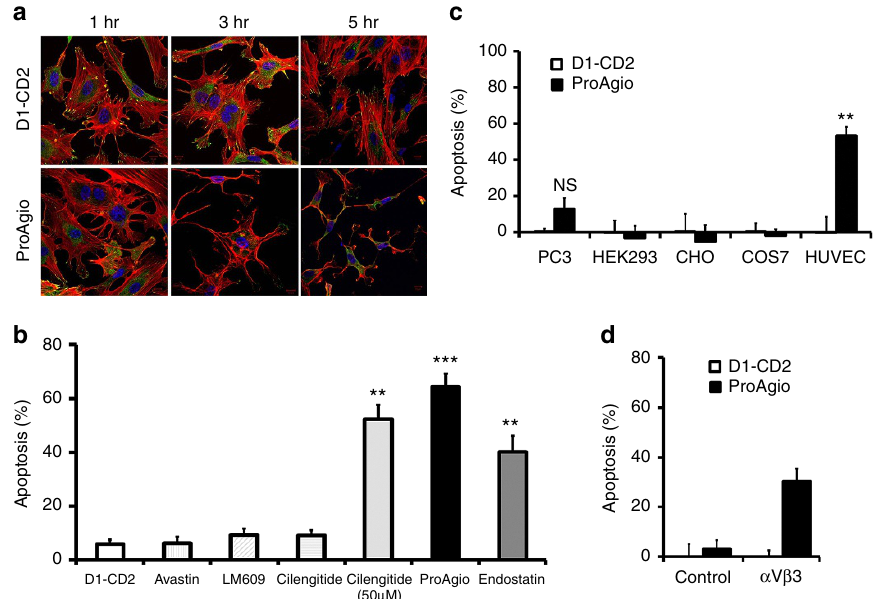
Figure 3 | ProAgio induces apoptosis via targeting integrin a v b 3 . ( a ) Representative confocal microscopic images of HUVEC cells stained by Rhodamine phalloidin (red), antibody against vinculin (green) and DAPI (blue). The cells were treated by the indicated protein agents for indicated times. ( b – d ) Apoptosis of various different cells (( b ) HUVEC, ( c ) indicated cells and ( d ) COS-7 with ( a v b 3 ) or without (Control) integrin a v b 3 expression) was measured by cell counting 24h after treatment with indicated agents. Cell apoptosis is presented as % apoptosis by defining the apoptosis of untreated cells as 0%. In all treatments, 5 m M (final concentration) of all agents were used except in one case in b wherein 50 m M Cilengitide was used (indicated). Error bars in b , c and d are s.d. from measurement of five independent experiments. NS P 4 0.05, ** P o 0.005, *** P o 0.001 calculated by unpaired two-tailed Student’s t -test. Scale bar in a is 10 m m. NS, not